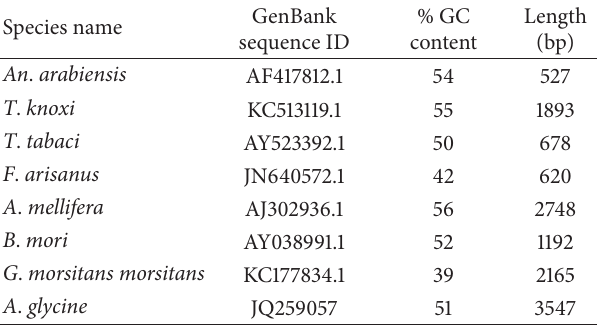
Table 1: Nanodrop readings for RNA samples: Brevicoryne bras- sicae , Thrips tabaci , whiteflies (Aleyrodidae), Anopheles arabiensis ,